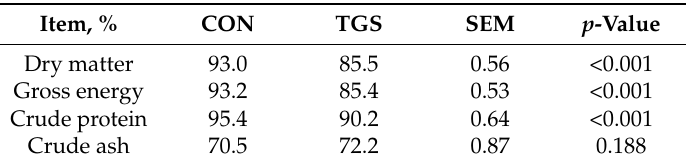
Table 7. Apparent total tract digestibility of pigs fed transglycosylated (TGS) or control (CON) starch diets. Item,